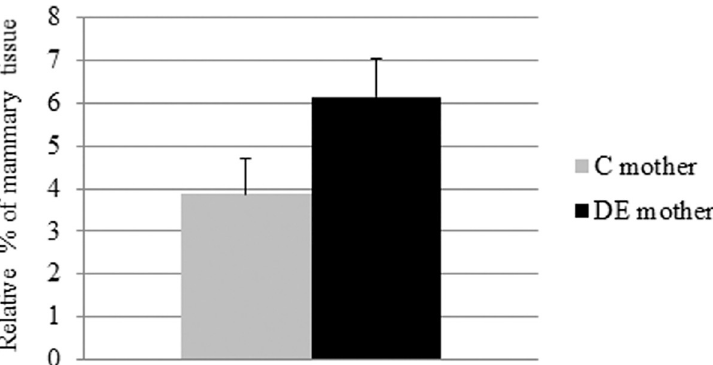
Fig 1. Quantification by stereology of the surface occupied by mammary ducts’ and alveoli’s lumina. Analyses were performed in C and DE-exposed rabbits at Day 28 of pregnancy using the Hamamatsu NanoZoomer Digital Pathology Virtual Slide Viewer and ImageJ software. Data are mean ± SEM.